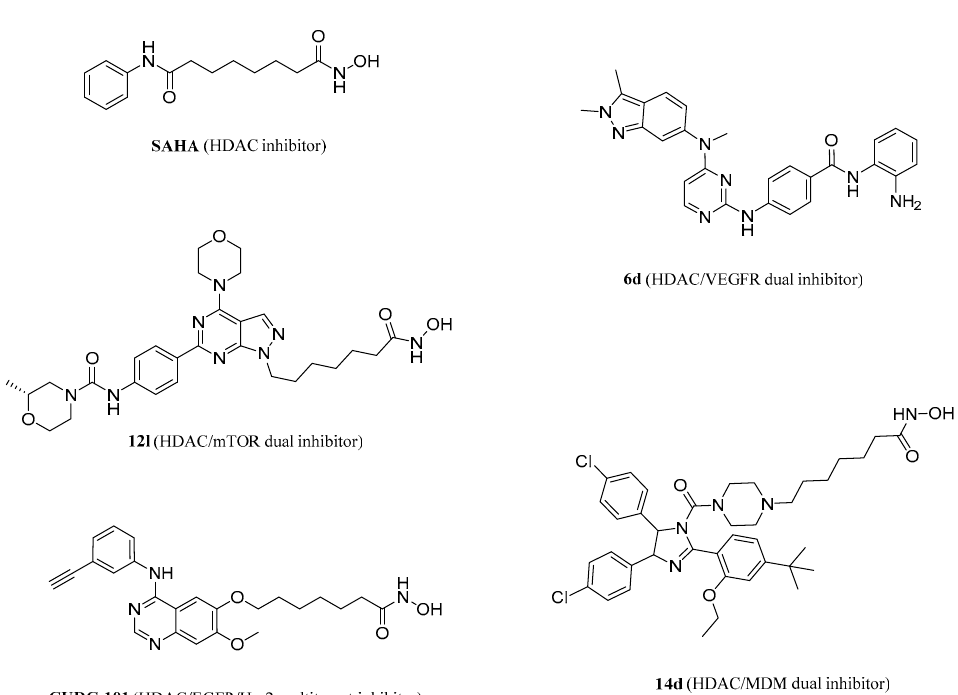
Figure 2. The structures of SAHA and several histone deacetylase (HDAC) inhibitor-based multi-target compounds.